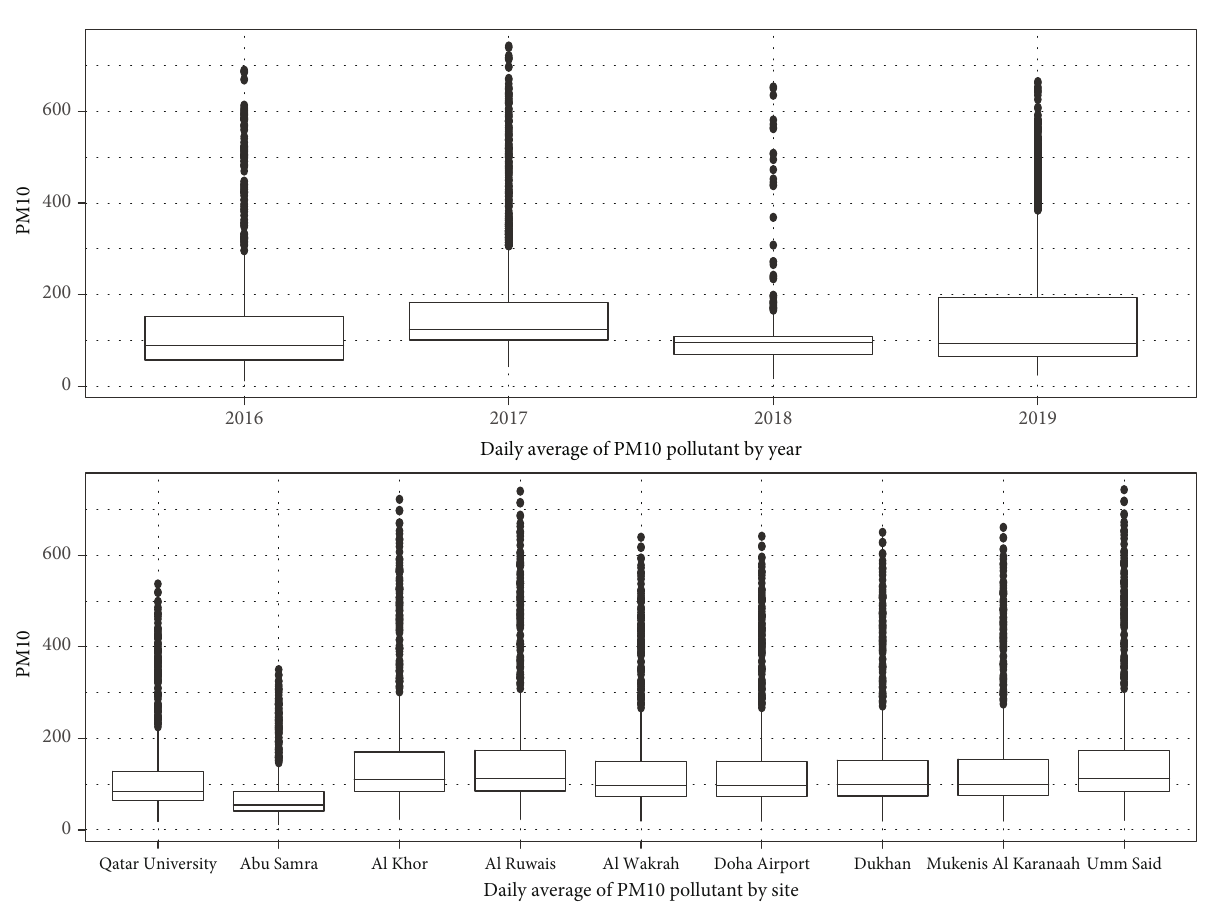
Figure 3: Boxplots of daily average of PM concentrations over the years 2016-2019 and by 9 locations in Qatar showing the quartiles; the 10 whiskers show the farthest observation from the